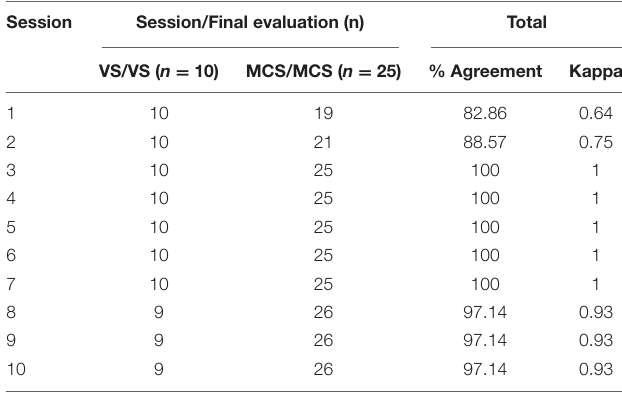
TABLE 2 | Agreement evaluation between the diagnosis in each session and the final diagnosis ( n = 35).